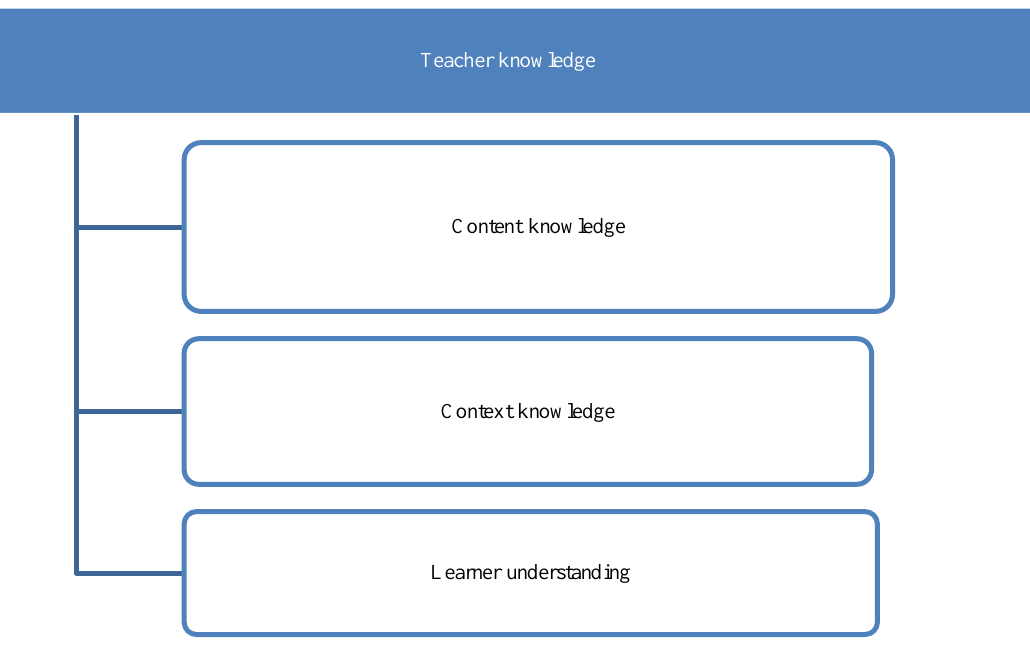
Figure 2: A schematic representation of the adapted theoretical